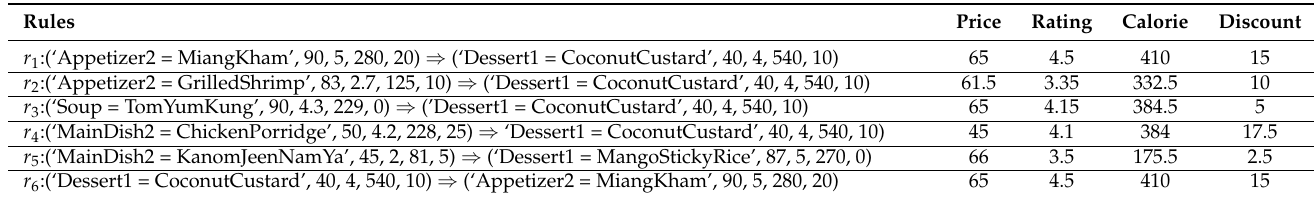
Table A1. Example for rules discovered by Apriori and averaged attribute